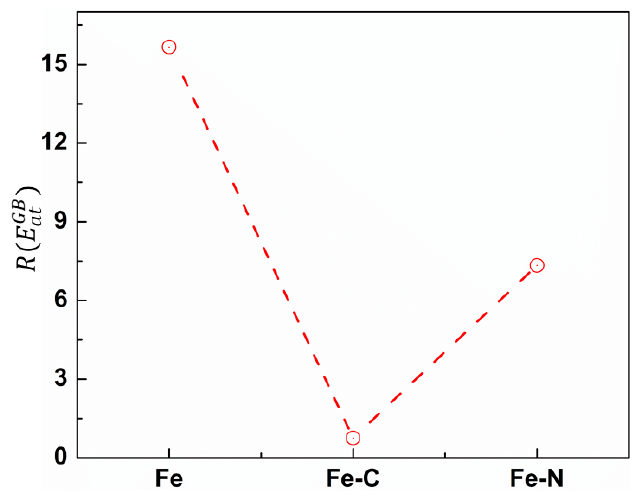
> E Fe E E > and those having ( ) GB Fe ) and those having ( E GB at coh at coh